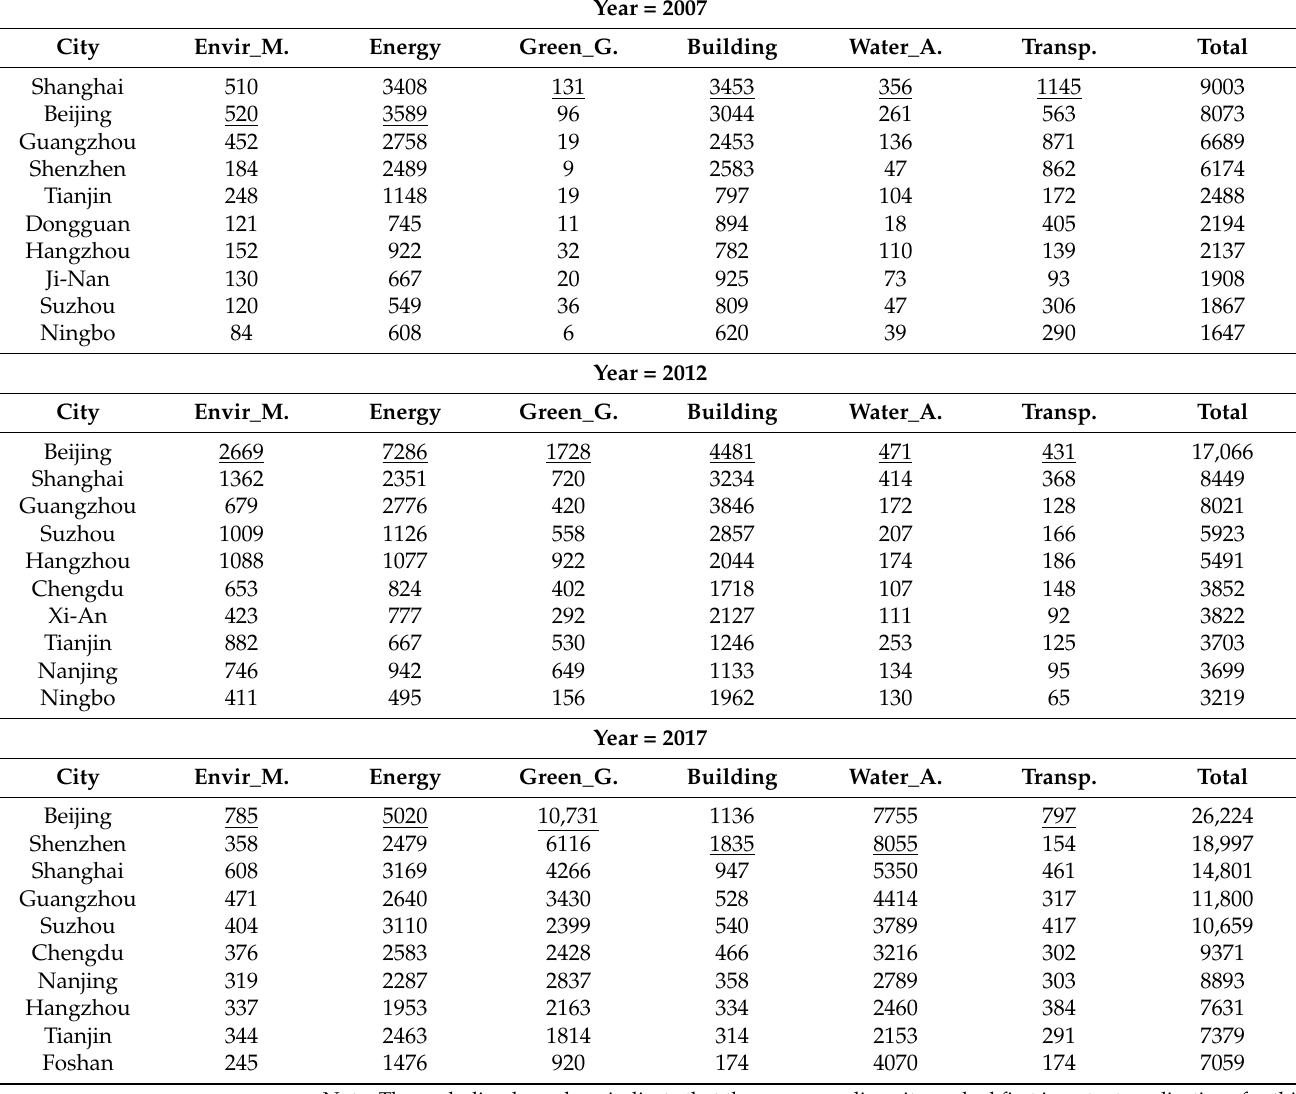
Table 5. Top 10 cities with the most environment-related technologies (2007, 2012, and 2017). Year =